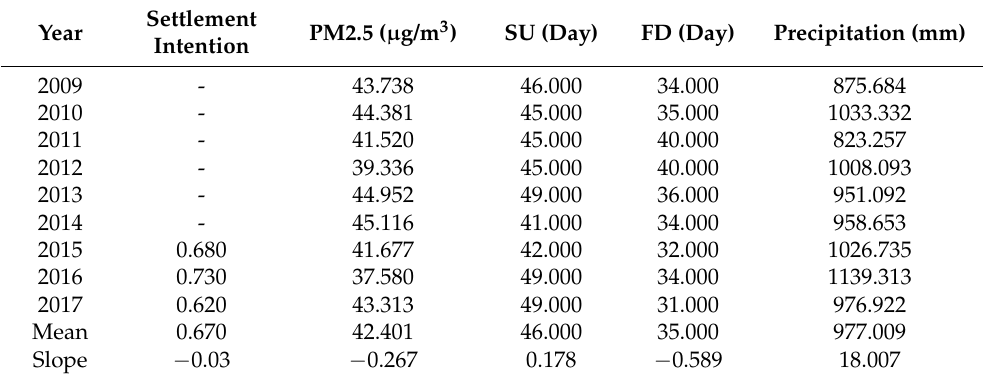
Table 2. Changes in elders’ settlement intention and natural amenity during the period of